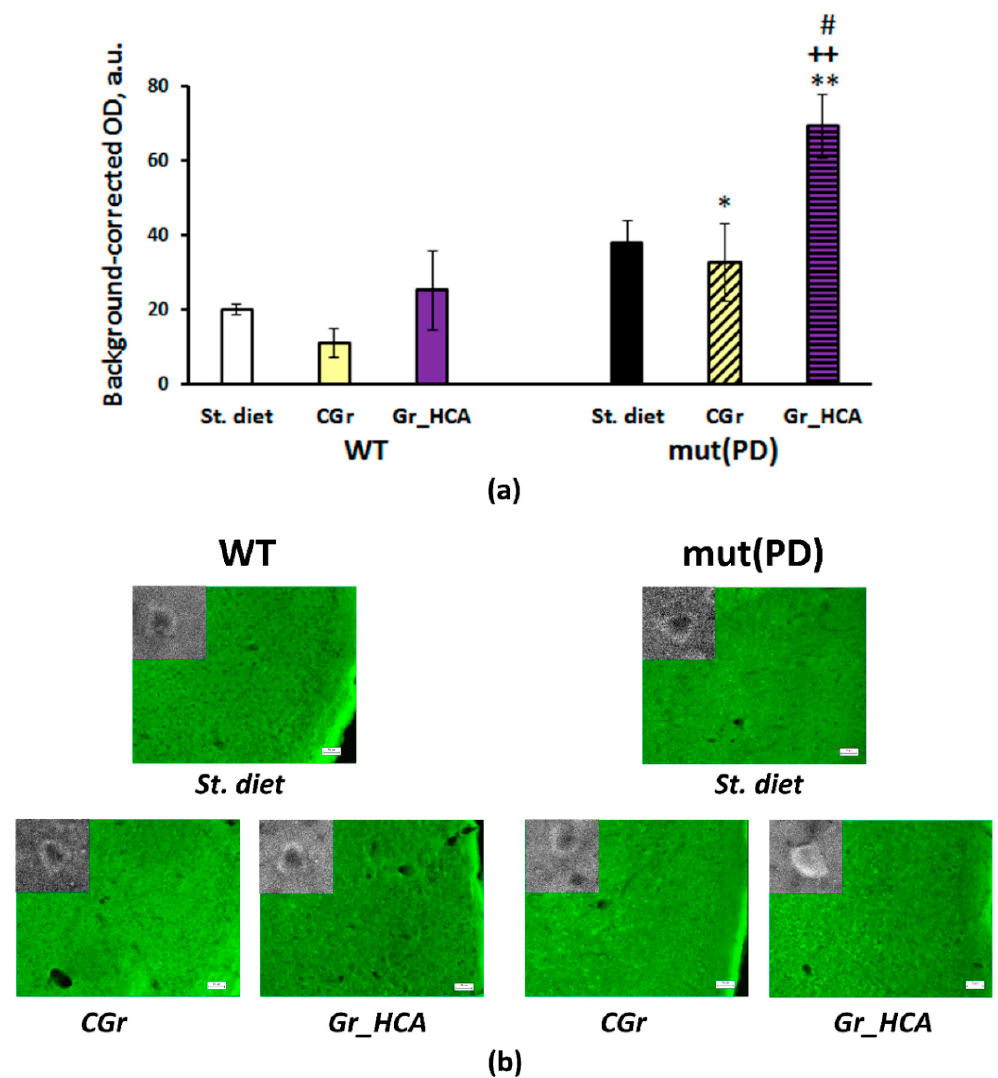
Figure 6. Effects of the type of diet and overexpression of α -synuclein (genetic PD model) on the expression of arginase 1 in the frontal cortex in mice. ( a ) Quantitative results. The data are expressed as the means ± SEMs of the values obtained in an independent group of animals ( n = 3–4 per group). Statistically significant differences: * p < 0.05, ** p < 0.01 vs. a respective WT group; # p < 0.05 vs. a respective group of mut(PD) mice given the standard diet (“mut(PD)+St. diet”); ++ p < 0.01 vs. a respective group of mut(PD) mice given the control grain diet (“mut(PD)+CGr”). ( b ) Arginase 1 immunoreactivity in the frontal cortex. Magnification, 200×; bar, 50 μ m. High magnification images (630×) of arginase 1-positive cells are shown in the insets.